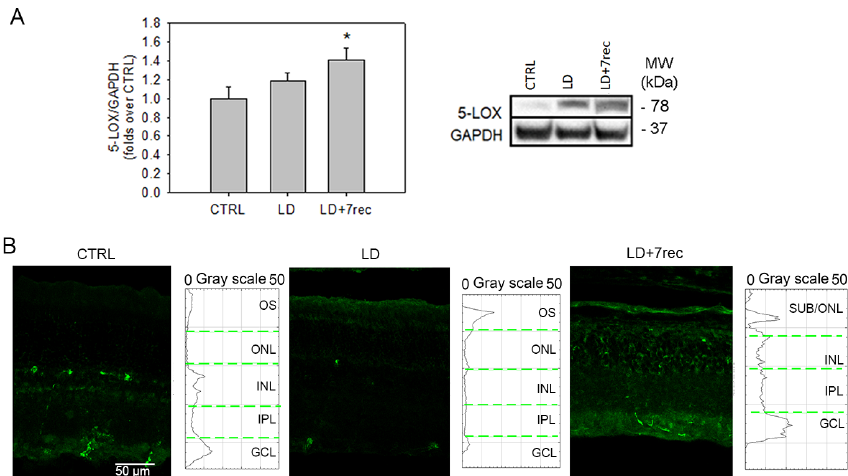
Figure 2. 5-LOX analysis. ( A ) Western blot analysis of 5-LOX in eye cup samples of all the experimental conditions. Statistical analysis was a one-way ANOVA test followed by Tukey test. Data are shown as mean ± SE ( n = 12). * p < 0.05 versus CTRL. The whole Western blot is available as Supplementary Figure S2. ( B ) Confocal images of retinal cryosections immunolabelled for 5-LOX (green) acquired at the central dorsal area of the retina. Scale bar: 50 µ m. The graphs show the plot profile fluorescence intensity of 5-LOX throughout the retinal layers. CTRL (Control); LD (Light damage); LD + 7rec (Light damage + 7 days of recovery); OS (outer segments); ONL (Outer nuclear layer); OPL (outer plexiform layer); INL (Inner nuclear layer); IPL (inner plexiform layer); GCL (Ganglion cell layer).